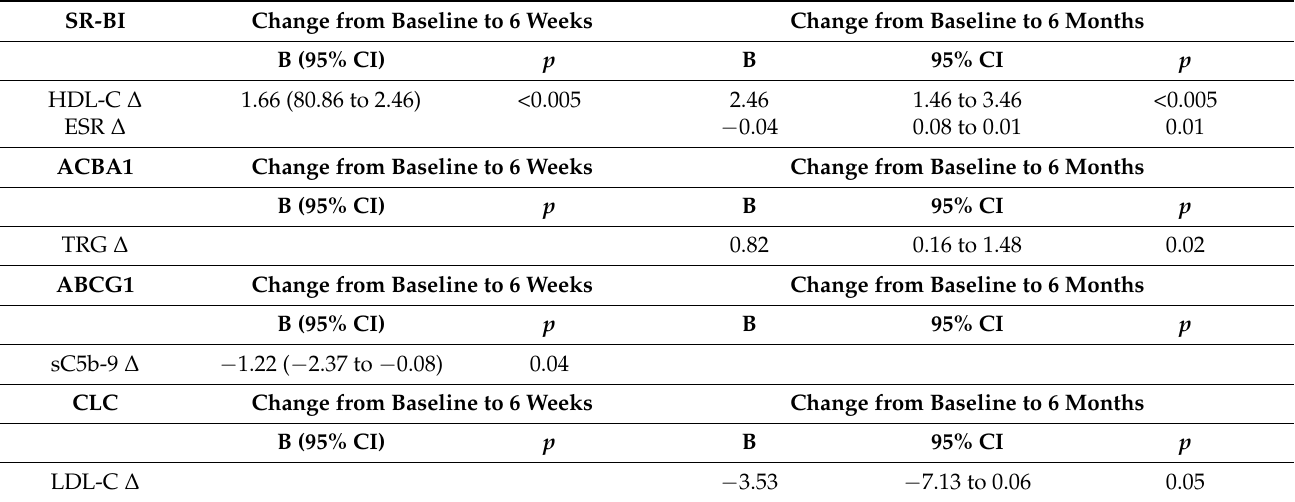
Table 5. Adjusted regression analyses: Variables with a statistically significant association to choles- terol transport parameters for changes from baseline to 6 weeks, and from baseline to 6